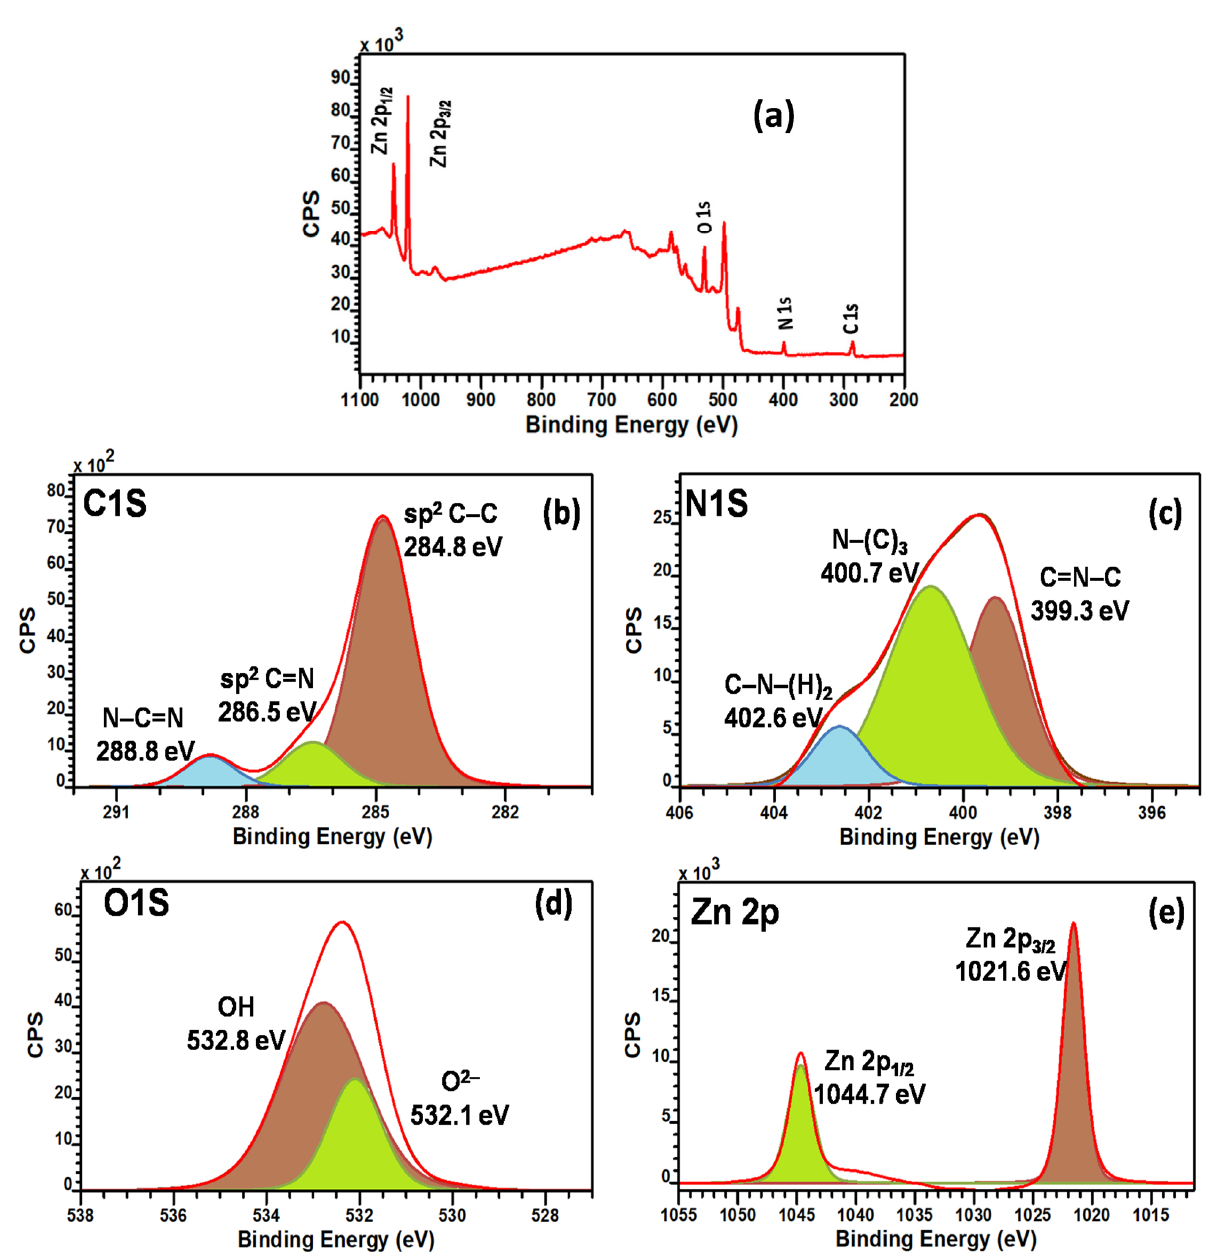
Figure 6. ( a ) Survey spectra, ( b ) C 1s, ( c ) N 1s ( d ) O 1s, and ( e ) Zn 2p XPS spectra of ZCN-5. The BET-specific surface areas of ZnO and ZnO/C 3 N 4 (ZCN-5) were found to be 33 and 61 m 2 /g, respectively. A typical type III isotherm with a hysteresis loop was observed in ZnO/C 3 N 4 (ZCN-5). The high surface area of the composite provided more active sites. resulting in high photocatalytic activity for the ZCN-5 composite (Figure 7).